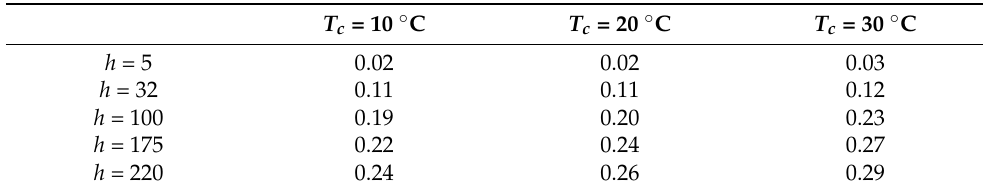
Table 12. Maximum exchange current density difference at the negative electrode ( ∆ i 0 ,n,max_diff ) in the discharge process (A/m 2 ).